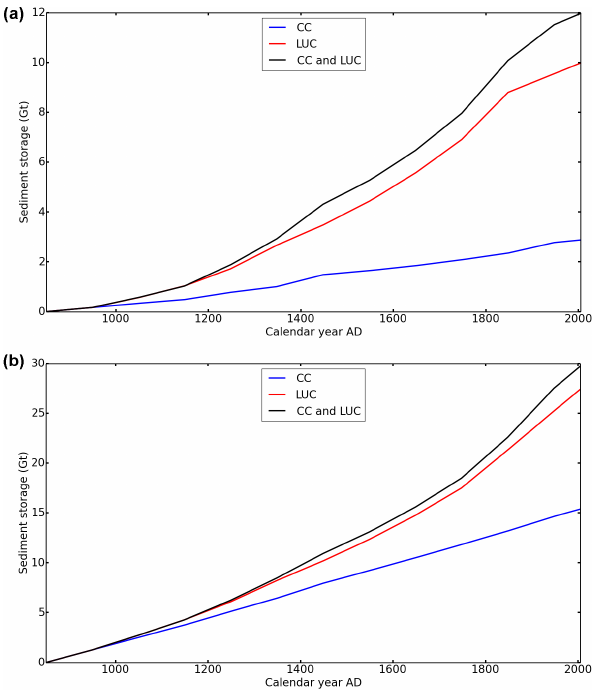
Figure 7. Simulated change in (a) floodplain and (b) hillslope sed- iment storage for the Rhine catchment during the last millennium. Shown is the sediment storage for the climate change simulation, where land cover is set to the conditions of the period AD850– 950 (CC – blue line), the sediment storage for the land use change simulation, where the climate is set to the conditions of the period AD850–950 (LUC – red line), and the sediment storage where both climate and land cover change during the last millennium (CC and LUC – black